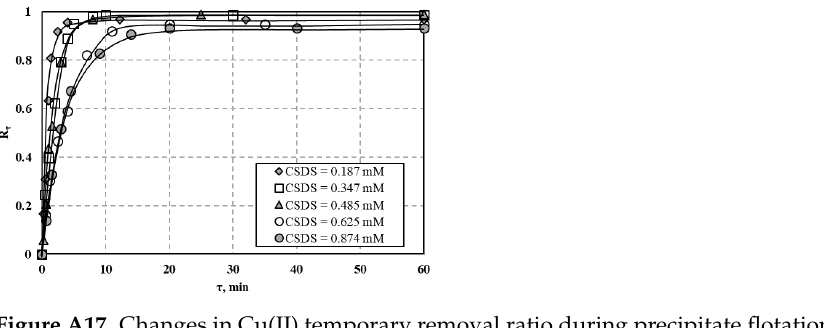
Figure A18. Changes in Zn(II) temporary removal ratio during precipitate flotation from solution containing Al(III), Cu(II), and Zn(II) mixture—effect of collector concentration (c 0 = 2 mmol dm − 3 , pH = 8.7, u G = 1.51 mm s − 1 ).